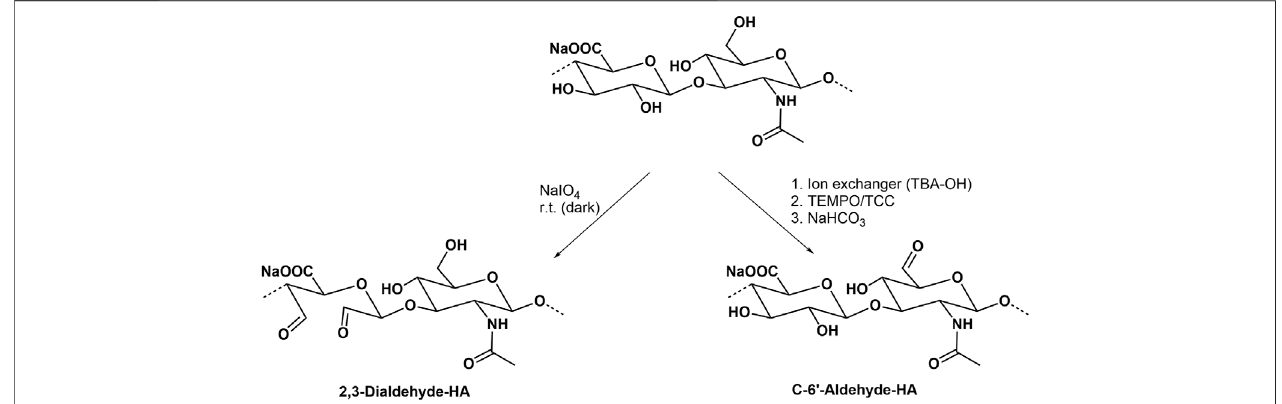
FIGURE 8 | Selective oxidation of hydroxyl groups of